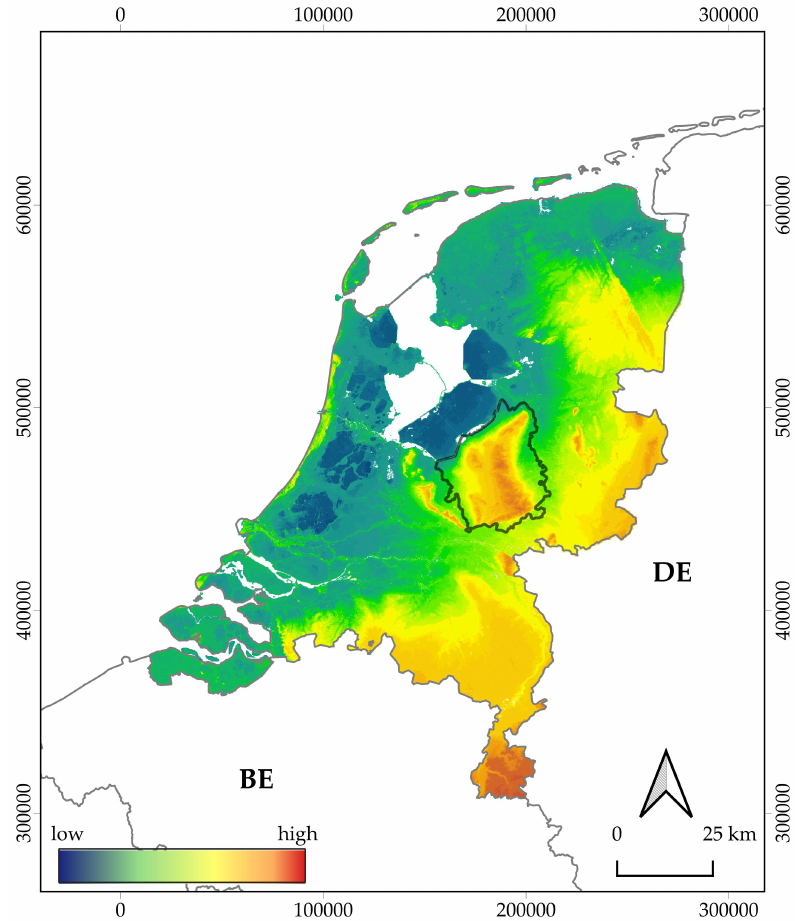
Figure 1. The research area on a height model of the Netherlands (source of the background image and elevation model: Ref. [24], coordinates in Amersfoort/RD New, EPSG: 28992; after Ref.